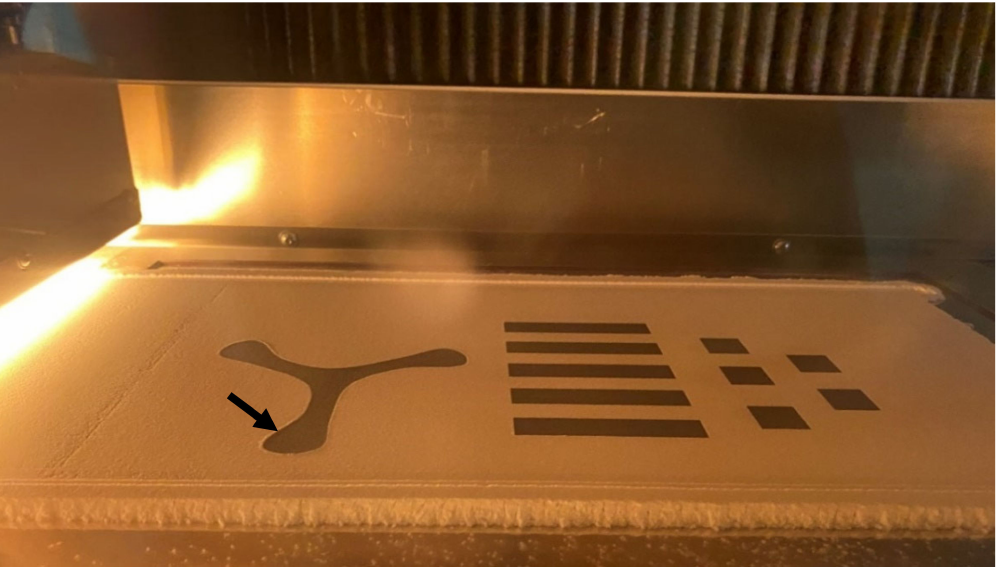
Figure 6. Ink jet printed powder areas are black before the sintering lamp is applied. The blades of the propeller were subject to mild curling ( arrow